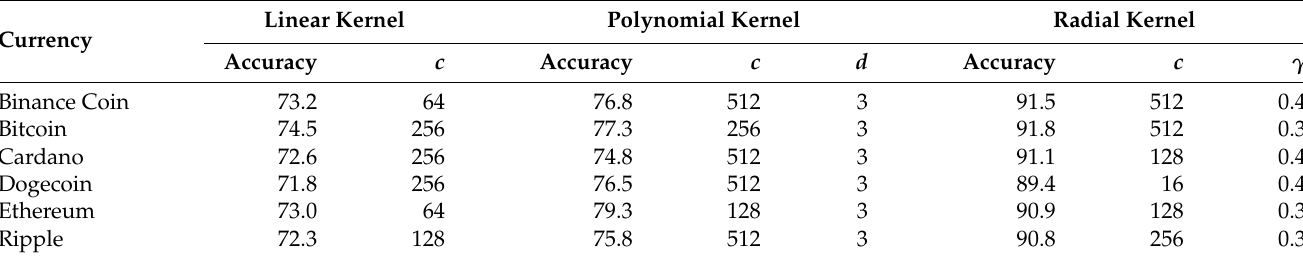
Table 4. Optimal parameters and performance accuracy (in %) for the indicated currency and kernel.